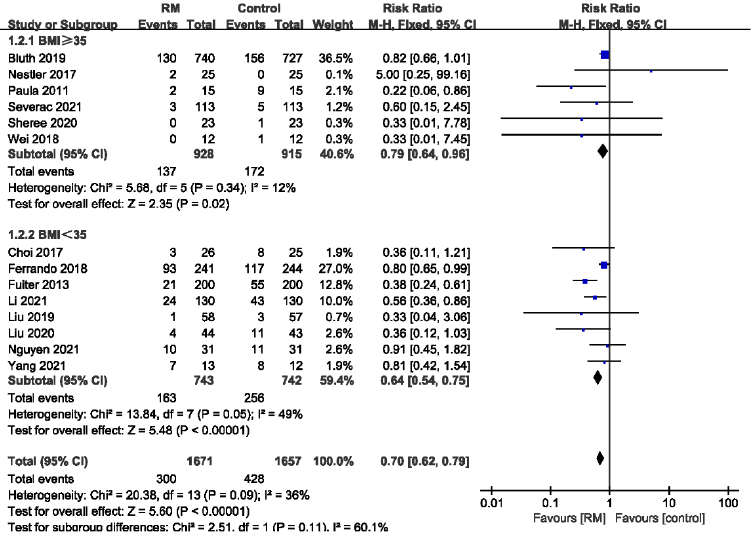
Figure 4. Forest plot for subgroup analysis of the incidence of PPCs between RM and control groups. Grouped by BMI: BMI ≥ 35 kg/m 2 , BMI < 35 kg/m 2 [17 – 28,30,31].